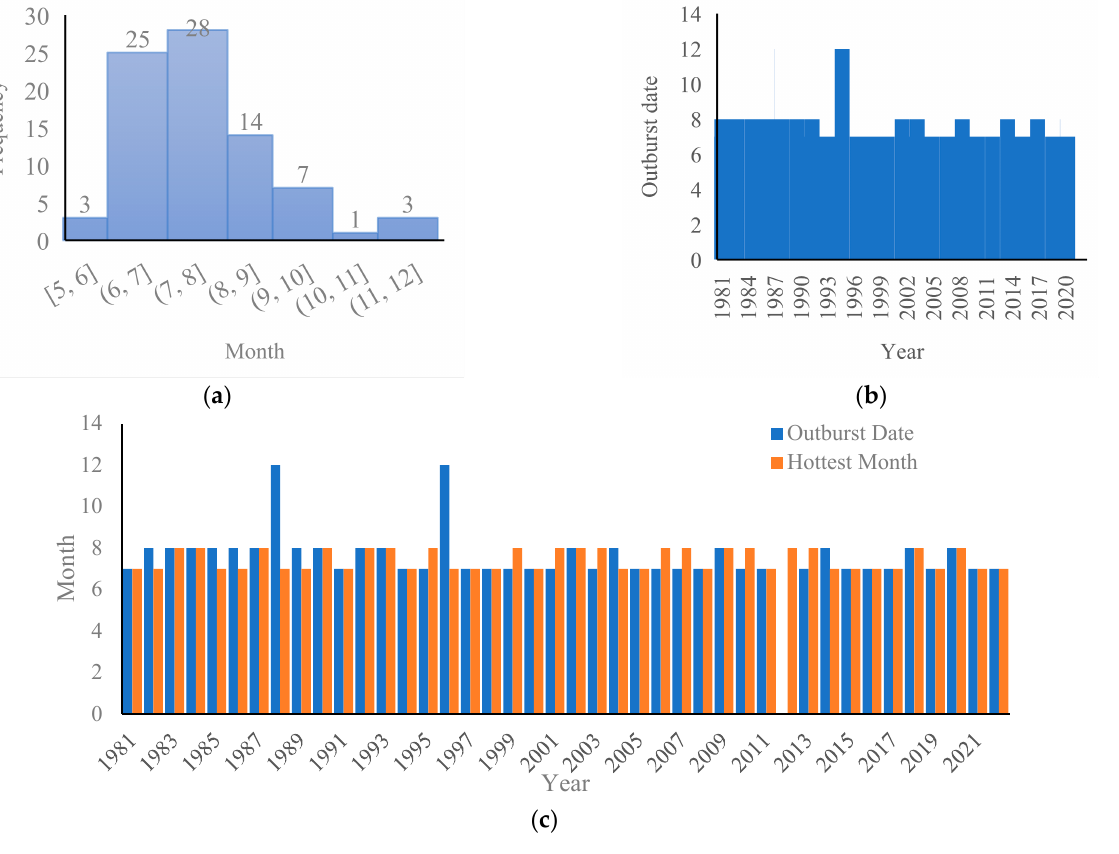
Figure 7. Date of Lake Merzbacher outburst since 1902. ( a ) Lake Merzbacher outburst Frequency in different months since 1902; ( b ) Lake Merzbacher outburst date since 1902; ( c ) The relationship between the outburst date and the hottest date since 1902.